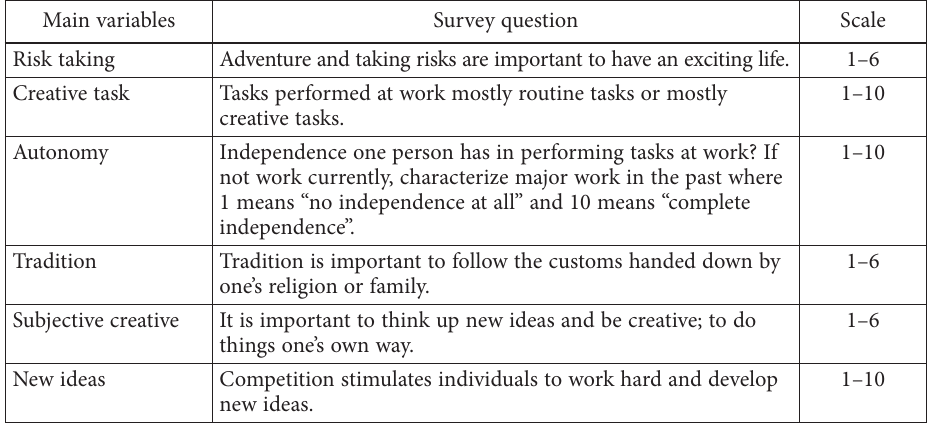
Table 1. Questions in survey (source: created by authors) Main variables Survey question Scale Risk taking